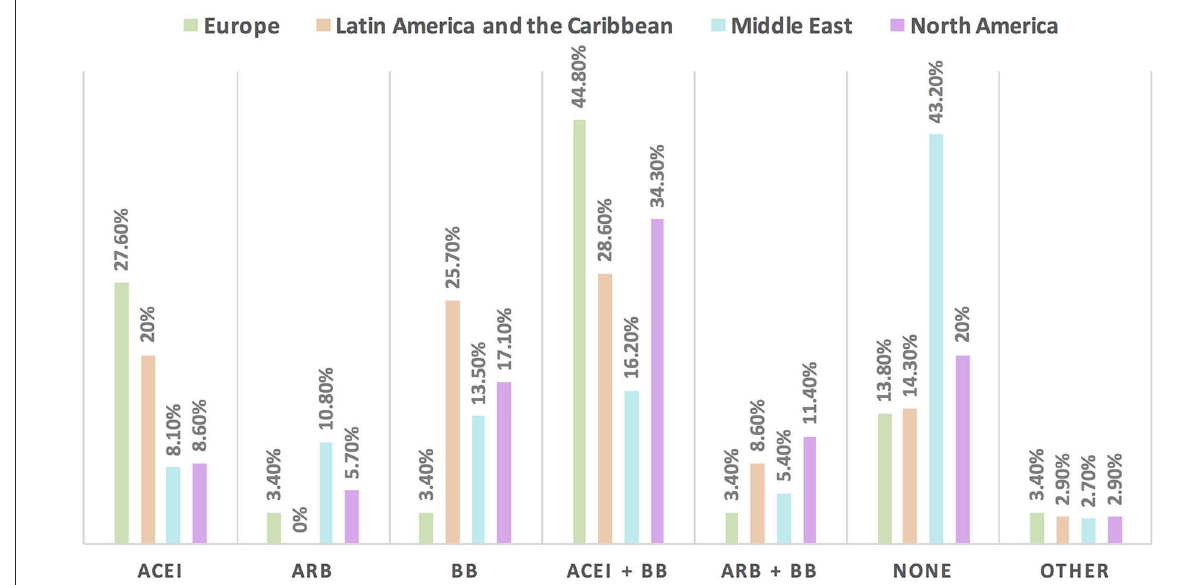
FIGURE8 The most commonly prescribed cardioprotective agents in patients with cancer and borderline LVEF [LVEF 50%] in different continents. A combination of ACEI and BB is the most commonly prescribed cardioprotective agent in patients with cancer globally. Of note, the highest rate of respondents who do not prescribe cardioprotective agents was found in the Middle East, because most of the respondents were oncologists. ACEI, angiotensin-converting enzyme inhibitor; ARB, angiotensin receptor blocker; BB, beta blocker.